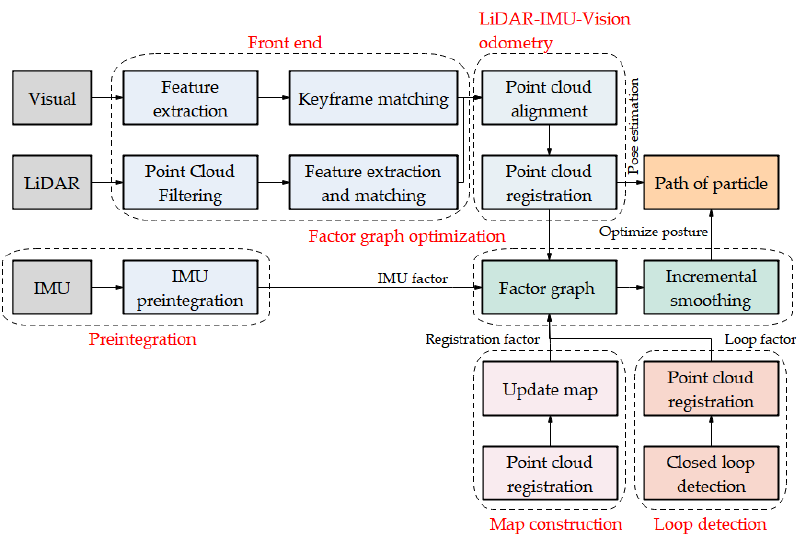
Figure 1. The overview of the system.